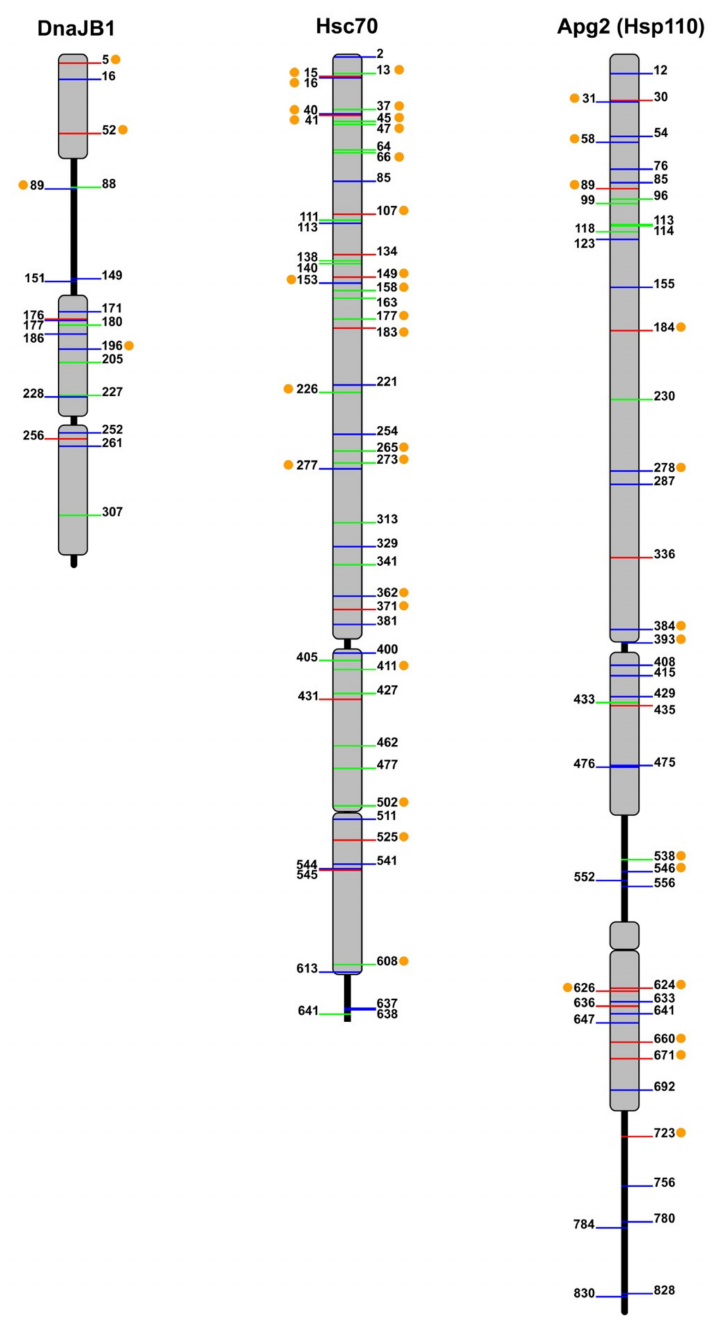
Figure 2. Mapping of phosphosites in representatives of the human Hsp40, Hsp70, and Hsp110 families. Phosphothreonines (green), phosphoserines (blue) and phosphotyrosines (red) listed in PhosphositePlus are shown for DnaJB1, Hsc70 (HspA8), and Apg2 (HspA4 or HspH2). Orange dots represent conserved residues in canonical, cytosolic members of the di ff erent chaperone families, which were found phosphorylated in at least two members of the corresponding